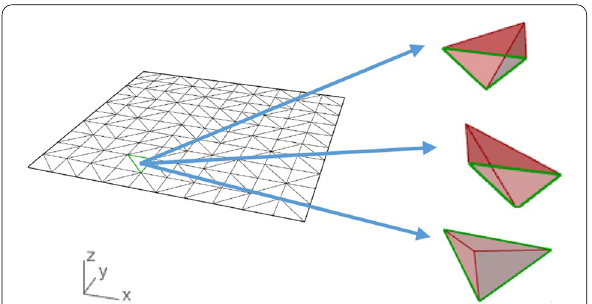
Figure 10 Elevated triangles after addition of height information to the planar STL file